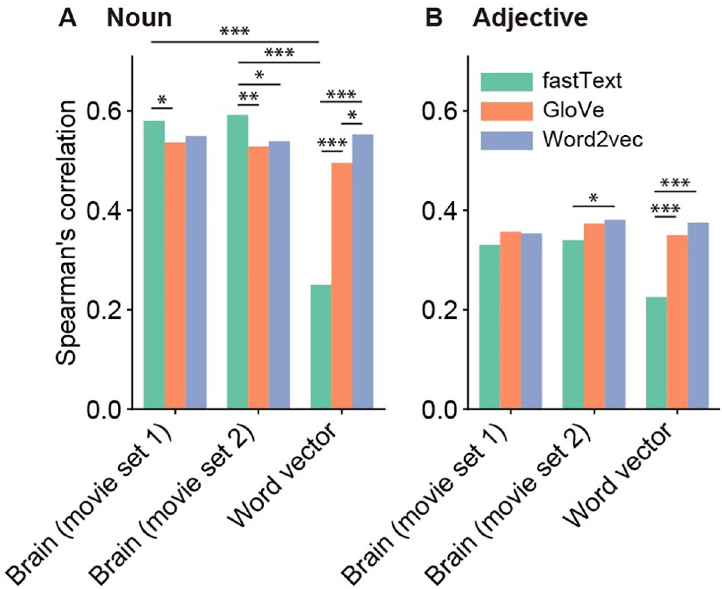
Fig 7. Behavioral correlates of brain-derived word dissimilarity for different word vector types. We computed brain–behavior and word vector–behavior correlations separately for the three types of 1000-dimensional word vectors (green, fastText; orange, GloVe; blue, word2vec). The Spearman’s correlation coefficients are separately shown for nouns ( A ) and adjectives ( B ). Marks above bars indicate the statistical significance of the correlation difference between different word vector types and between brain–behavior and word vector–behavior correlations (permutation test, ��� p < 0.0001, �� p < 0.01, � p < 0.05, FDR corrected).